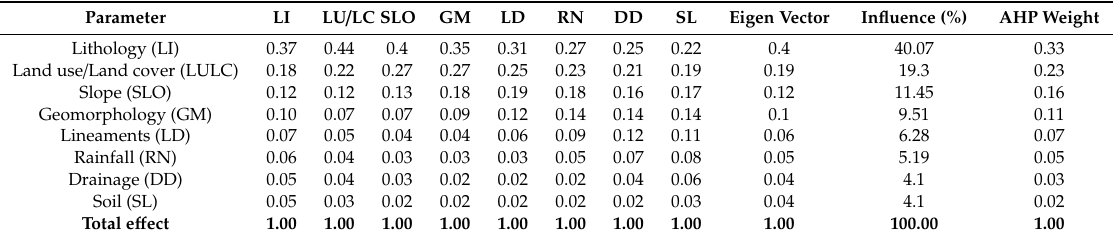
Table 4. Standardized pairwise comparison matrix and weight factors influencing